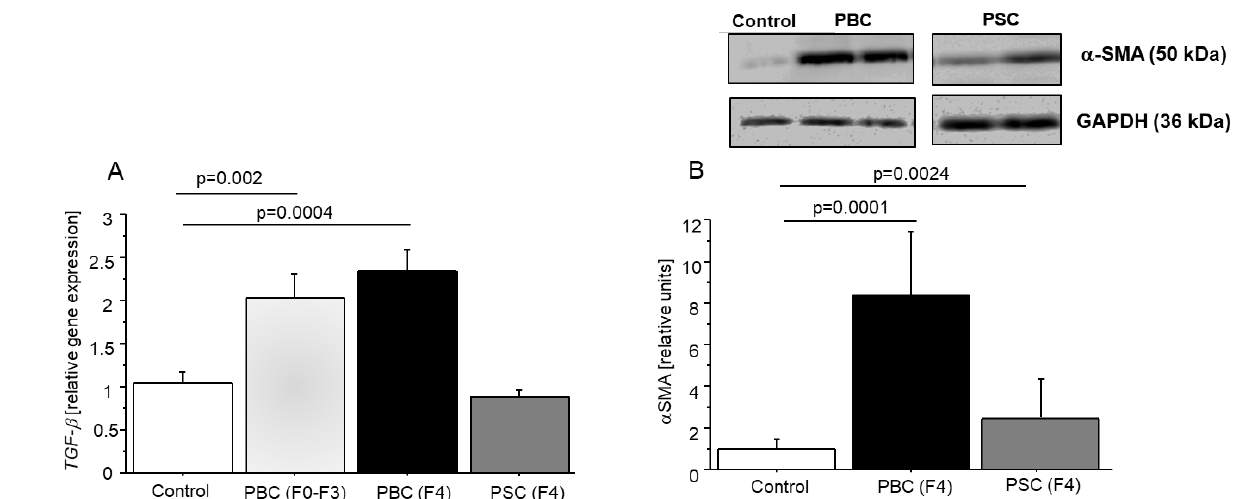
Figure 5. The elevated expression of TGF- β and the level of α -SMA in cirrhotic (PBC, PSC) and control liver tissues. The relative gene expression of TGF- β in liver tissues at early stage (F0–F3; n = 18) and cirrhotic stage of PBC (F4; n = 10) and PSC (F4; n = 10), which was measured by quantitative PCR (real-time PCR) ( A ). Western blot analysis revealed the protein expression level of α -SMA in cirrhotic PBC (F4; n = 10) and PSC (F4; n = 10) tissues ( B ).